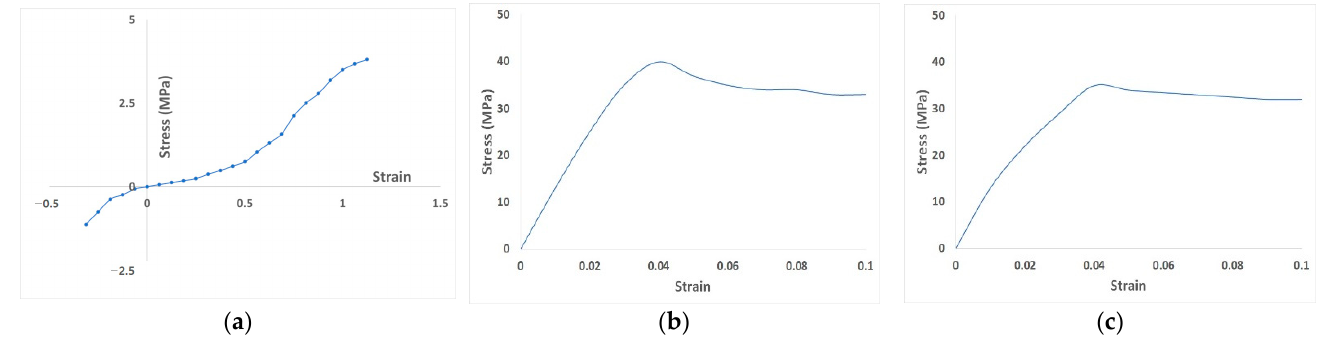
Figure 1. Normal tooth-alveolar bone FE model verified in a previous study [21].